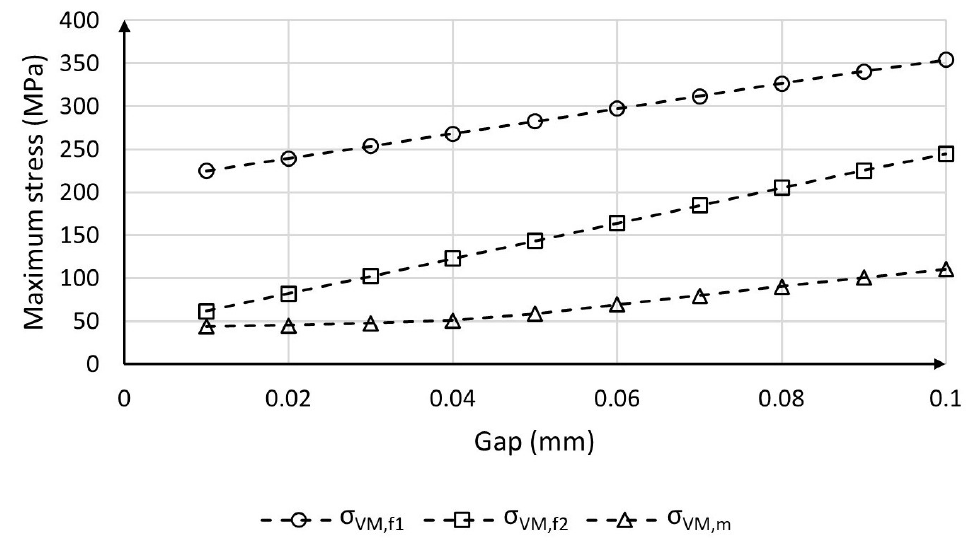
Figure 6. Maximum stress on fillets and membrane as a function of the gap (@p = 6 bar).